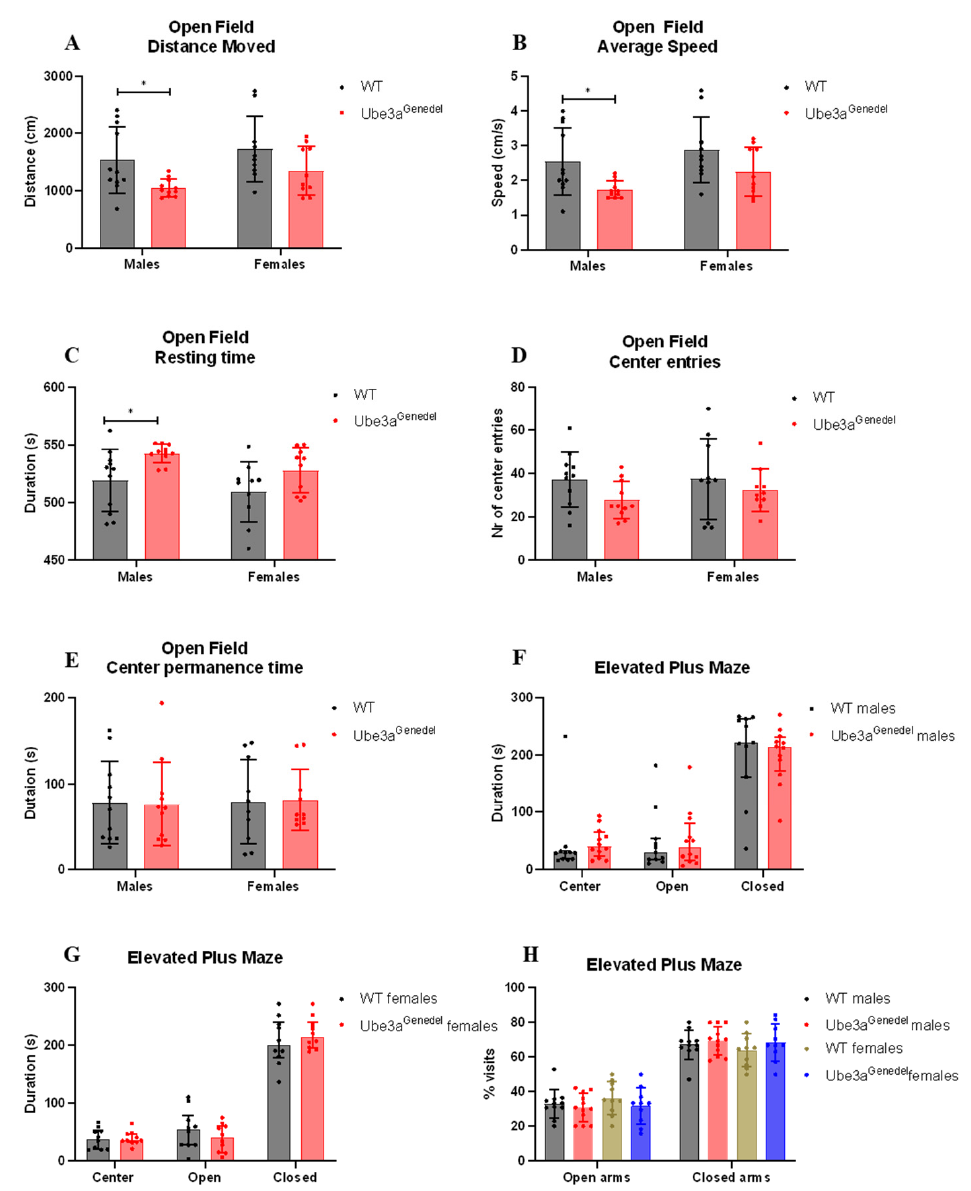
Figure 3. Activity and assessment of general anxiety with open field and elevated plus maze. ( A – E ) The performance in the open field for the parameters total distance moved, average speed, resting time, center entries, and center permanence time. The Ube3a genedel mice exhibited increased resting time, while the total distance moved and average speed were decreased; two-way ANOVA with dependent measurements genotype main effect, p < 0.01, depicted with means ± SD. ( F – H ) Time spent in the center, open, and closed configuration of the EPM, showing no significant alteration in duration or percentage between the genotypes; robust ANOVA of aligned rank transformed data with dependent measurements genotype main effect, p > 0.05, depicted with medians and interquartile ranges. Significant effects of genotype are indicated as * p < 0.05 for genotype significance.